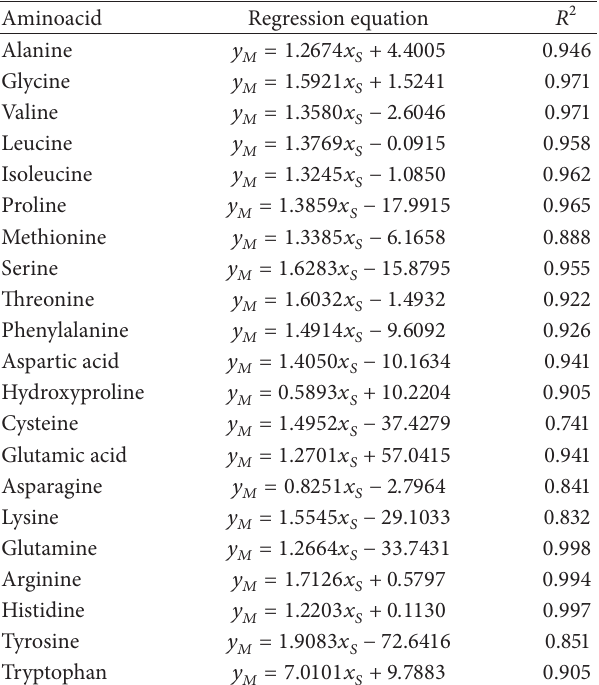
Table 3: Regression equations and coefficient of determination ( 𝑅 2 ) between the content of each amino acid extracted with stomacher ( 𝑆 ) and mixer mill ( 𝑀 ) as homogenization tools.